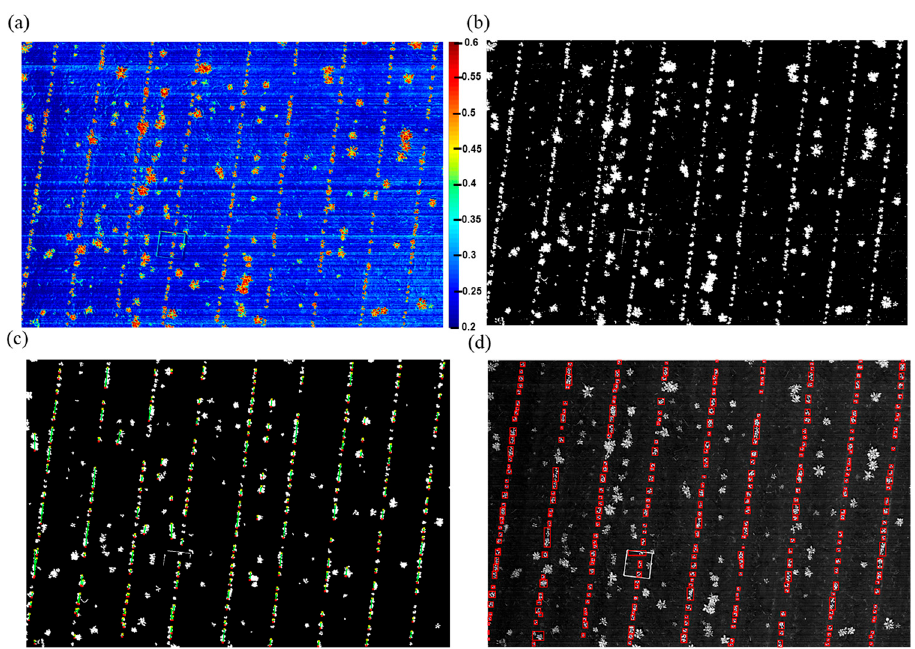
Figure 6. Illustration of the segmentation process of cotton seedlings based on an NDVI image. ( a ) An NDVI image of a portion of field. There was a square of PVC pipe in the fourth cotton row from the left; ( b ) Binary image converted using a threshold NDVI <0.35 to remove soil; ( c ) Binary image after removing noise (small objects) and large weeds. The green dotted lines shown in the image were the detected rows based on the Standard Hough Transform. The red dots and yellow dots mark the beginning and the end of the detected parts within a row; ( d ) Detected cotton seedlings or clusters of seedlings. The red boxes mark the regions of interest (ROIs) that contained a single cotton seedling or a cluster of connected cotton seedlings.